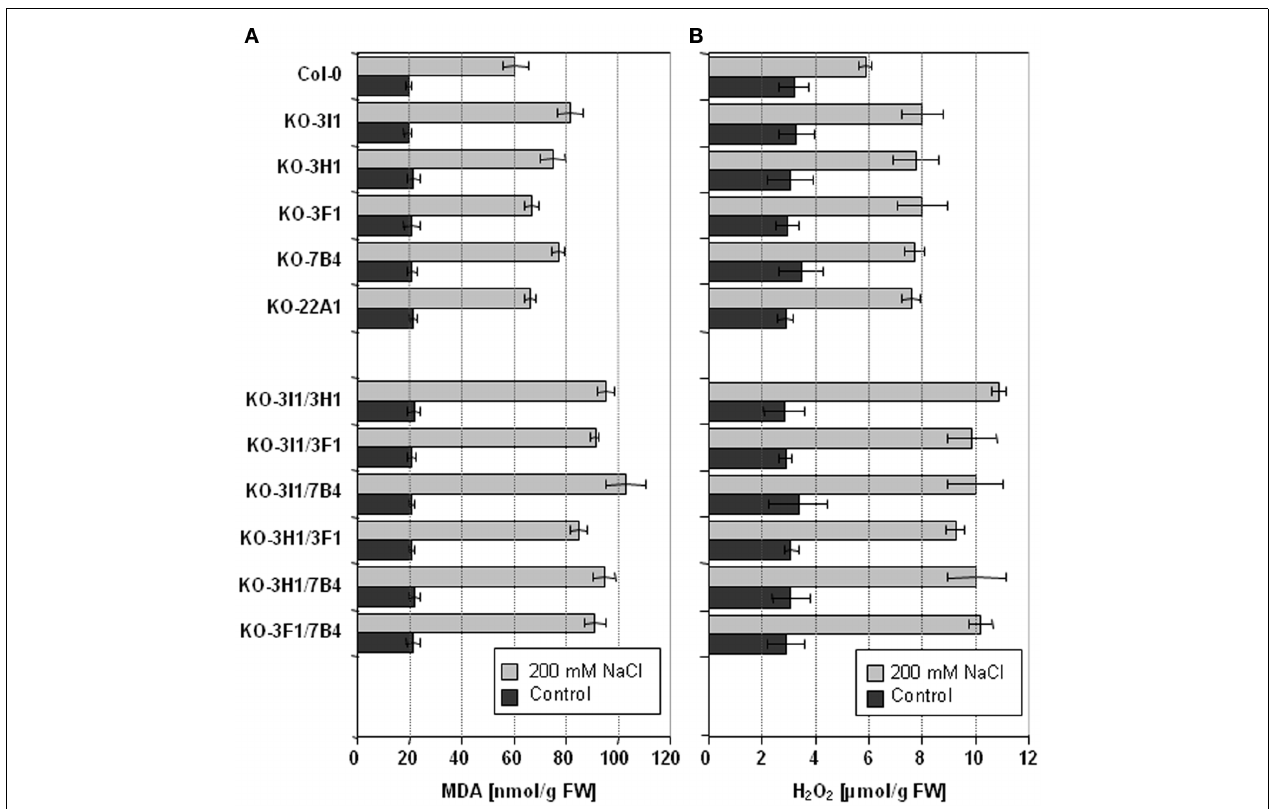
Lipid peroxidation was determined as the amount of malondialdehyde (MDA) accumulating as an end product of lipid peroxidation (Sunkar et